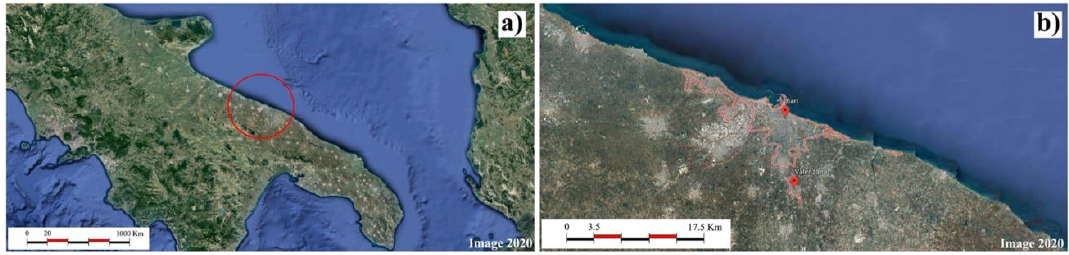
Figure 1. Google Earth image of ( a ) geographic location of Bari and ( b ) Bari and Valenzano areas.